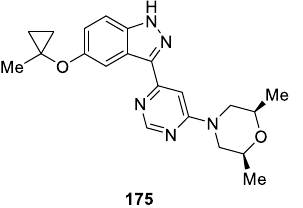
Figure 56. Chemical structure of 1 H -indazole derivative 175 as LRRK2 inhibitor.